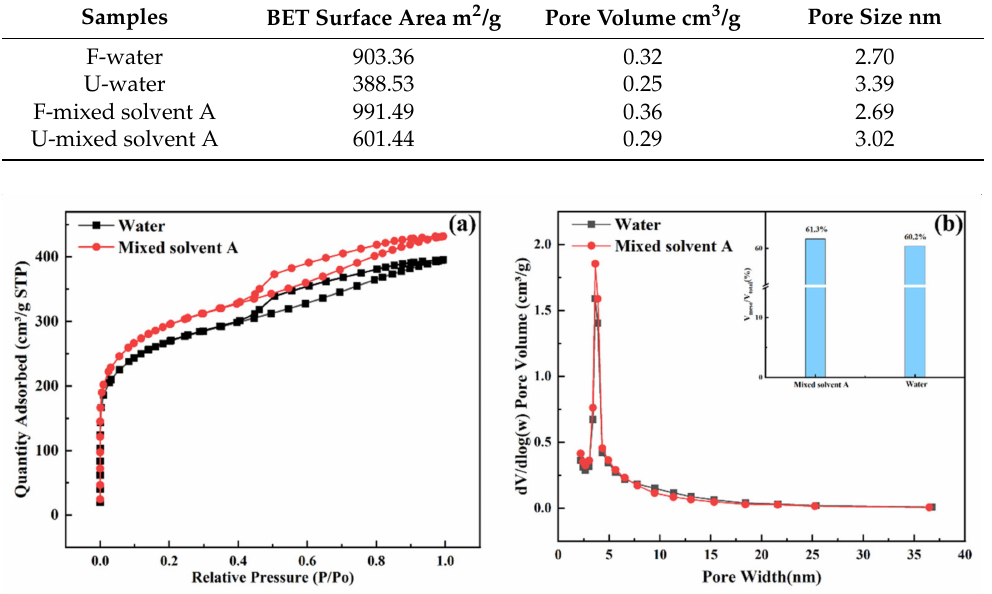
Figure 6. Catalyst adsorption/desorption isotherms ( a ); catalyst pore volume pore size distribution and distribution of mesopores to total pore volume ( b